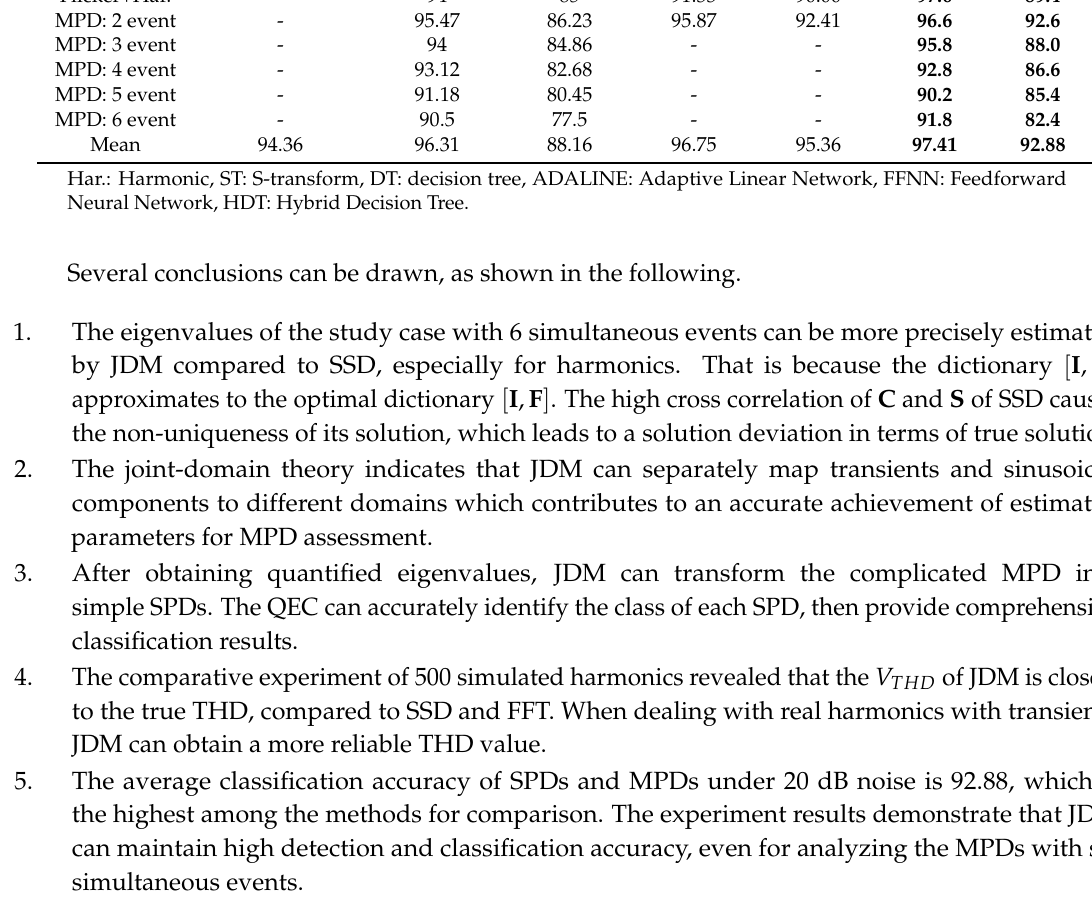
Table 6. The comparison of the classification accuracy of JDM and advanced MPD analytical method. PD Event Noise level